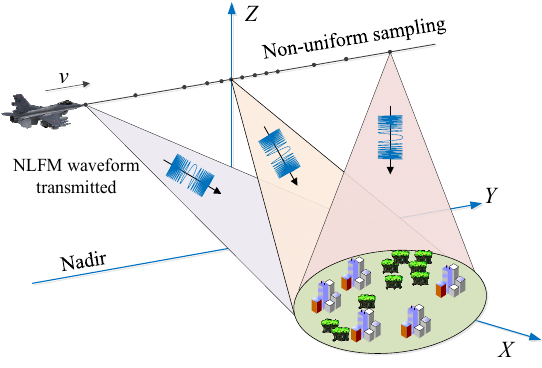
Figure 5. Imaging geometry of starring spotlight with NLFM waveform and ANUS.